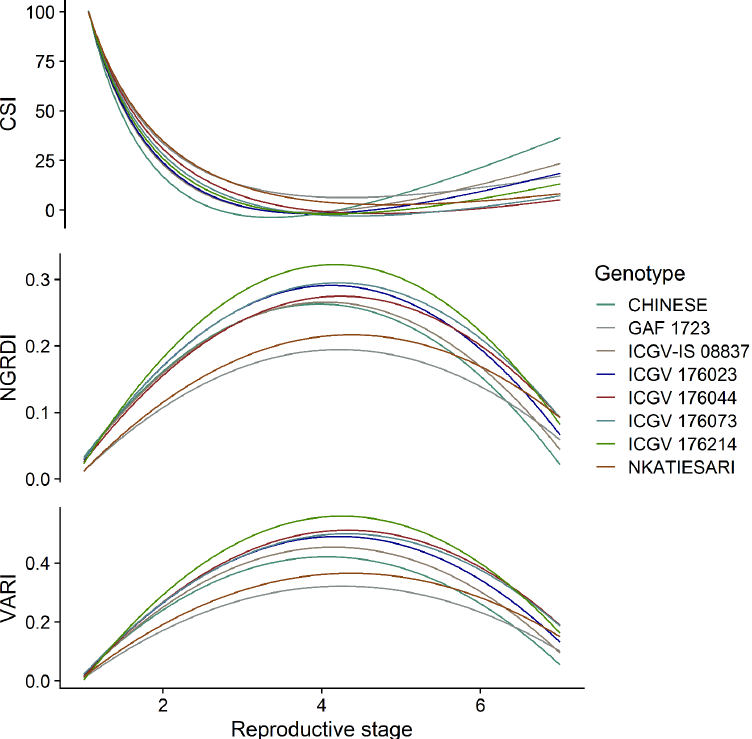
Figure 2. Crop senescence index (CSI), normalized green red difference index (NGRDI) and variable atmospheric resistance index (VARI) of selected medium duration (MD) and short duration (SD) genotypes.